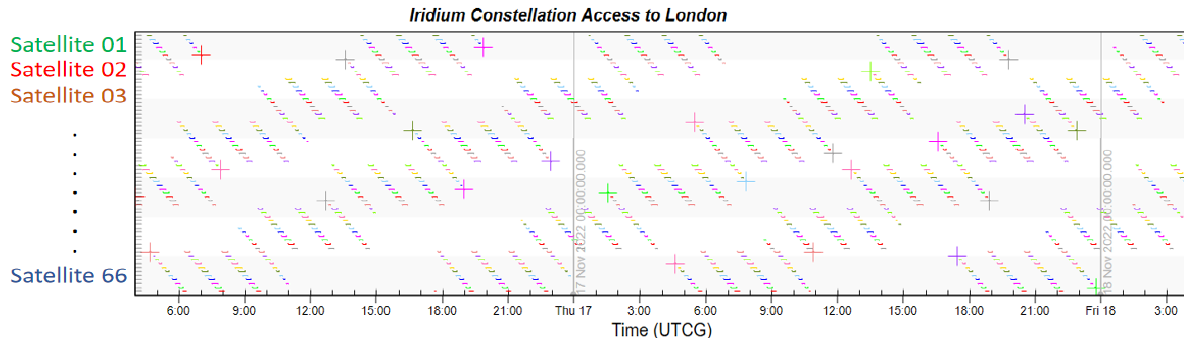
Figure 12. Constellation access to Sydney.